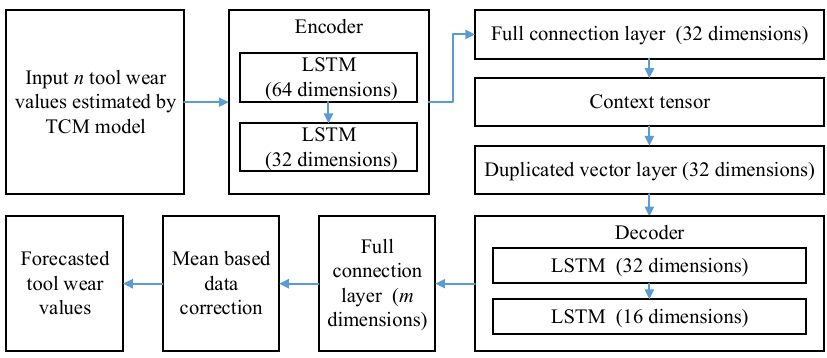
Figure 6. LSTM network.